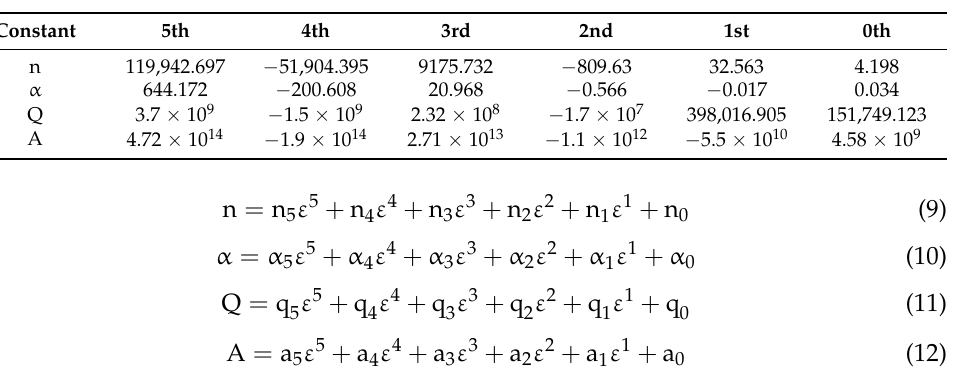
Table 2. Coefficient of